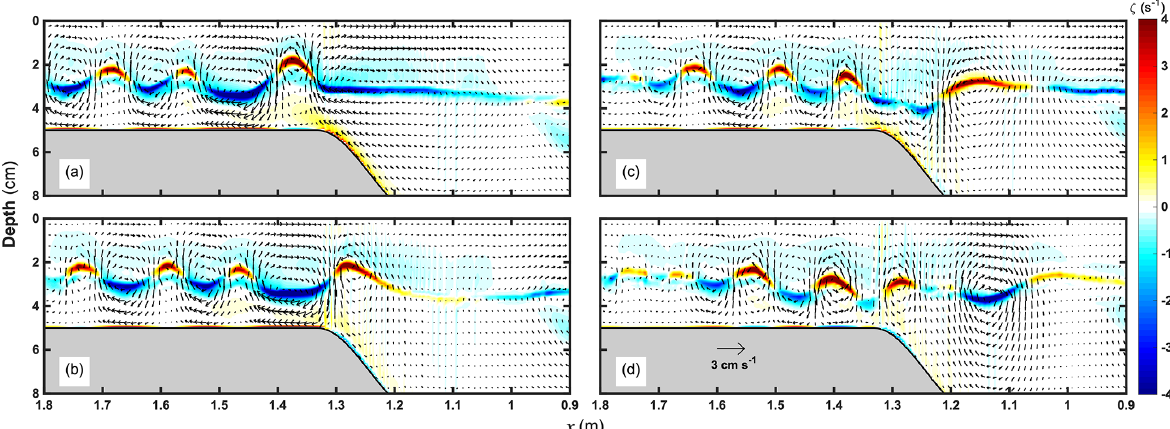
Figure 11. As in Fig. 10, the elevation wave propagates westward to the deep water; the x axis is inverse for convenience at t = (a) 115, (b) 120, (c) 125, and (d)